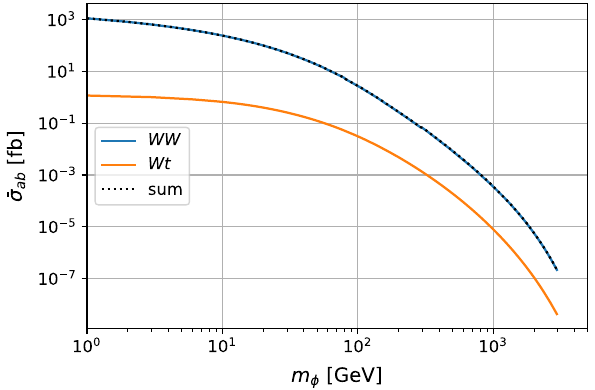
Fig. 1 Cross section contributions of Eq. (8) as a function of m φ for the process pp → W φ at the LHC with a CM energy of 13TeV. The dotted black line indicates the sum of the individual